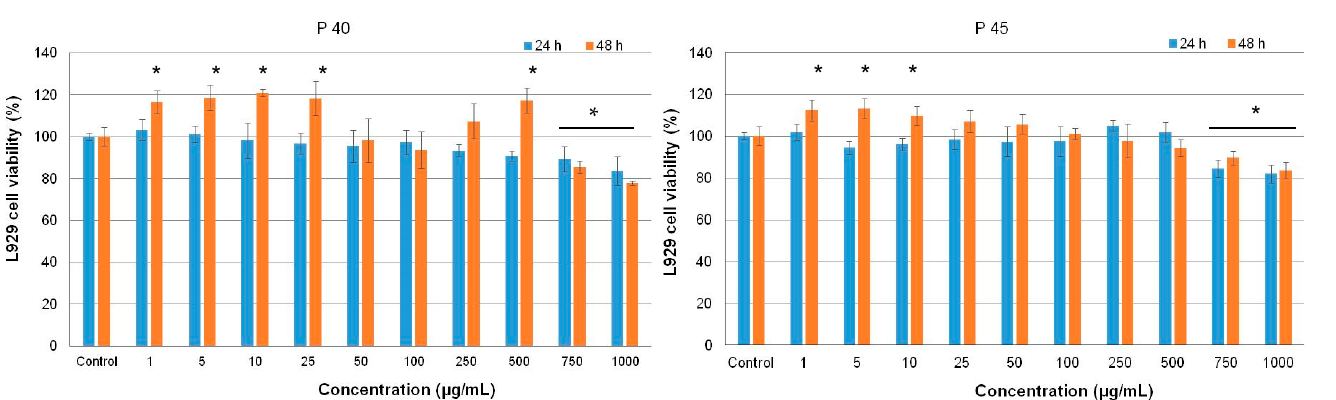
Figure 4. Representative light micrographs of HT-29 cells cultivated in the presence of different concentrations of P40 (second line) and P45 (third line) microencapsulated materials, for 48 h. The untreated culture served as control (first line). (Giemsa staining). Bar scale = 100 µm.